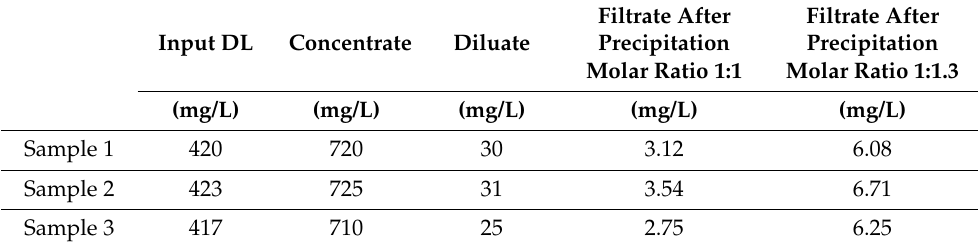
Table 6. Phosphate content in input and output